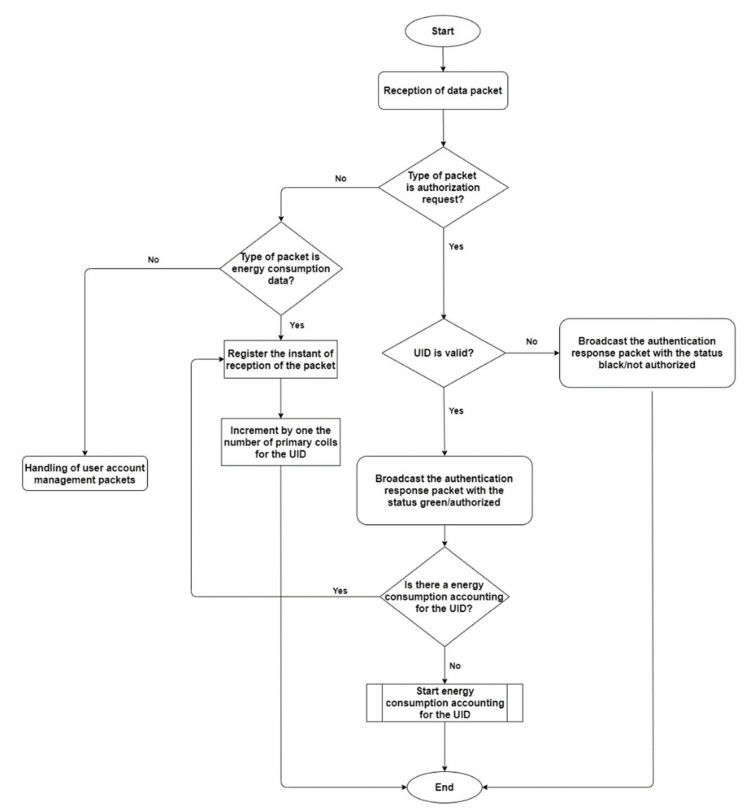
Figure 4. Flowchart of the processing of packets received from the DIWPT lane on the server.